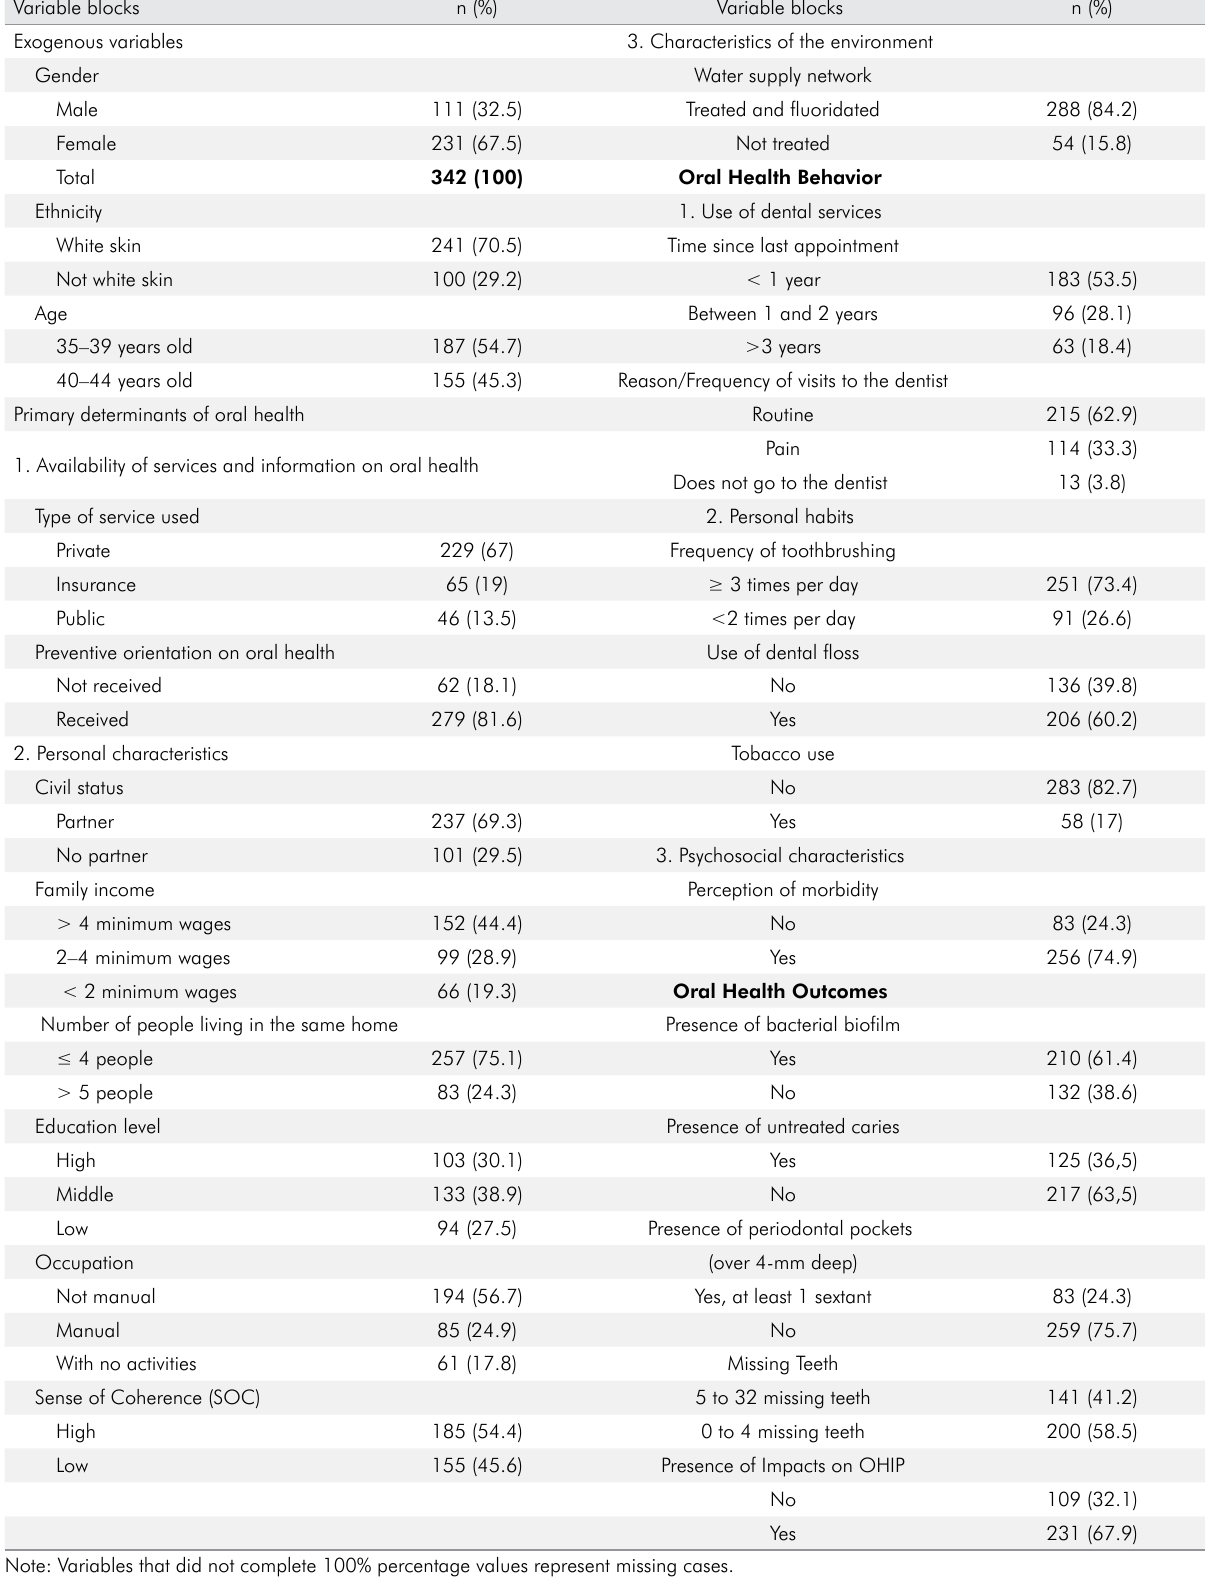
Table 1. Demographic, socioeconomic, psychosocial and clinical characteristics of adult residents in Jundiaí, Brazil, 2014. Variable